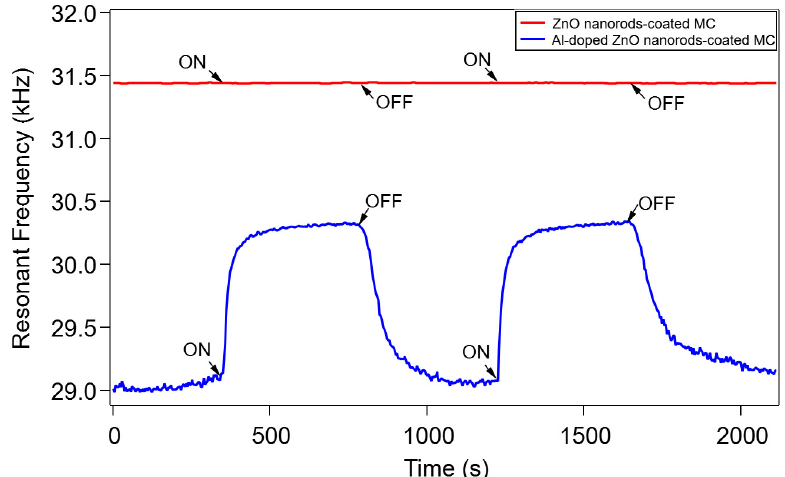
Figure 7. Comparison of CO response between Al-doped ZnO nanorod-coated MC (blue solid line) and undoped ZnO nanorod-coated MC when CO gas was flow either on, with flow rate of 200 mL/min, or off. The graph also shows no resonant frequency change for the undoped ZnO nanorod-coated MC (red solid line) upon gas exposure.